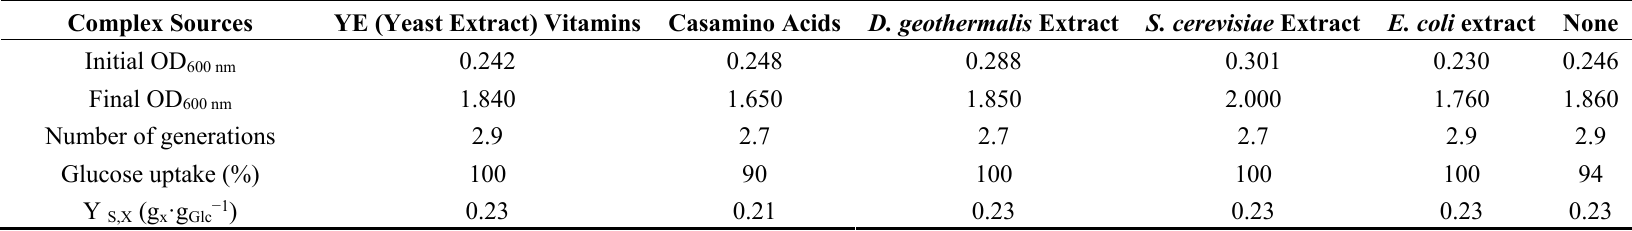
Table 8. Effect of five complex sources on the results of growth of Deinococcus geothermalis DSM-11302 in DMG. Complex Sources